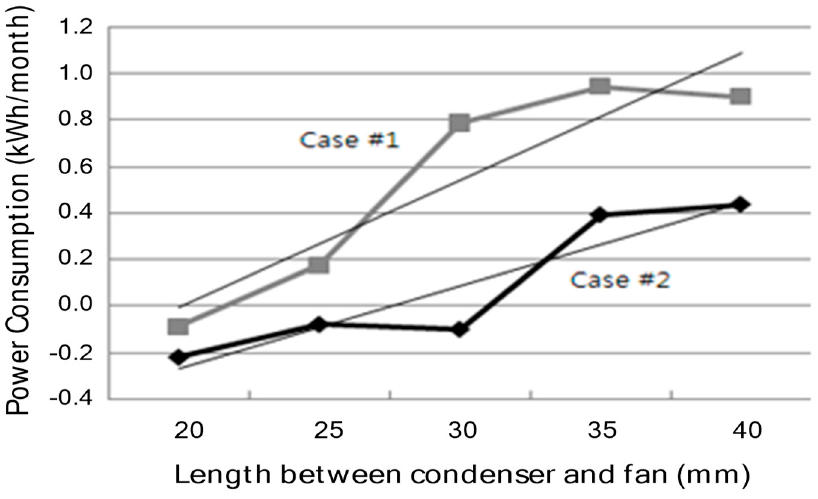
Figure 10. Monthly power consumption for various lengths between the condenser and the fan.